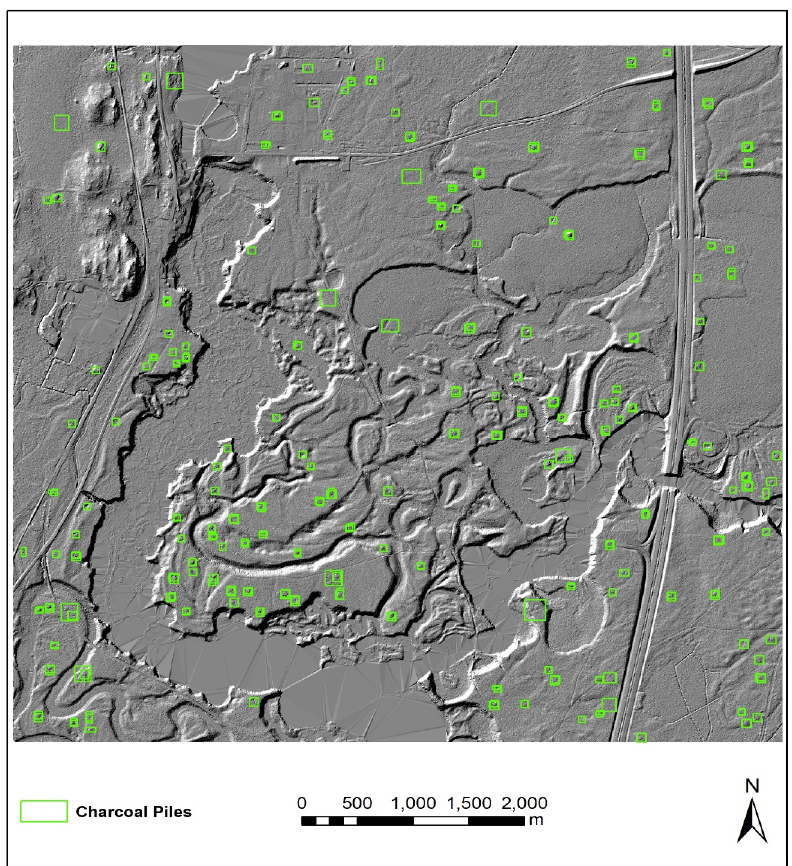
Figure 8. Total distribution of charcoal piles identified by the methods used in this study. Approxi- mately 180 piles were detected between hydrological depression and RetinaNet analyses.